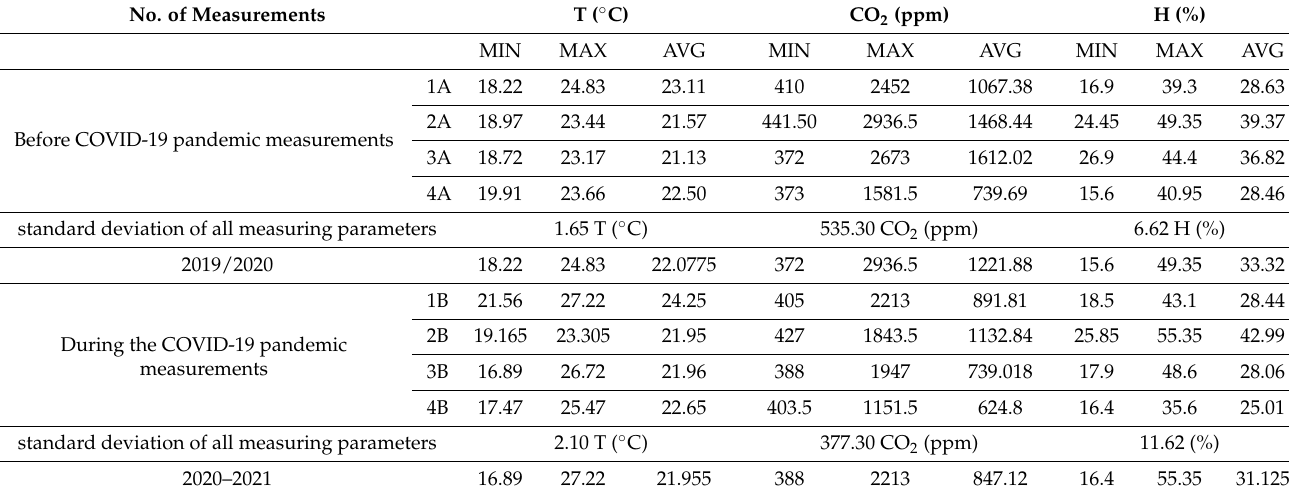
Table 4. Measured parameters: air temperature Tai, relative humidity RHai, and carbon dioxide concentration CO2 (MIN—minimum measured value; MAX—maximum measured value; AVG—average measured value during the children’s presence in the kindergarten) in the winter period before and during the COVID-19 pandemic.